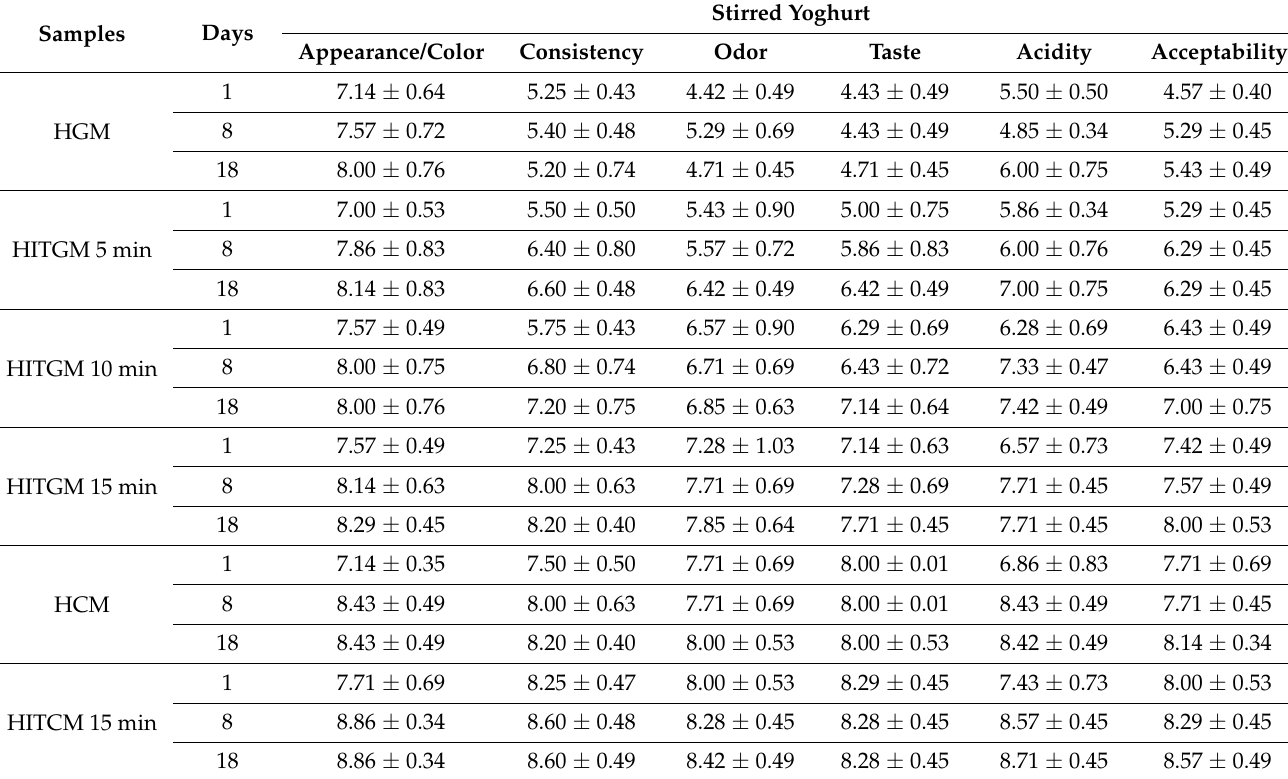
Table 3. Sensory evaluation of stirred yoghurt samples during the storage period (panelists: n =